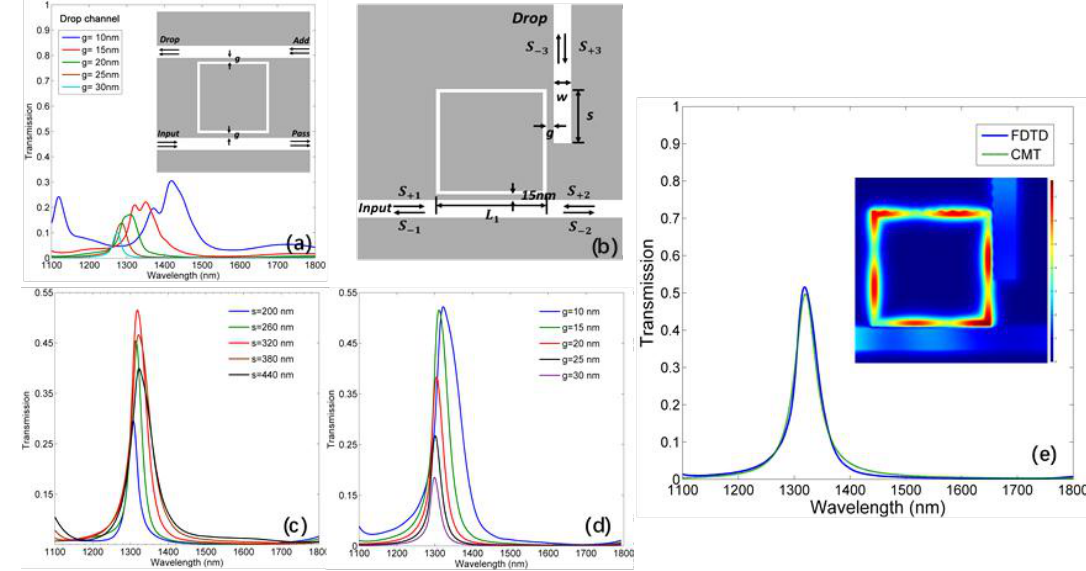
Figure 2. ( a ) The drop spectrum for the traditional add-drop SRR. ( b ) The schematic diagram of the band-pass filter. ( c ) The drop spectrum pertinent to different coupling lengths. ( d ) The drop spectrum pertinent to different gaps. ( e ) The transmission spectrum for a channel drop filter with L 1 = 546 nm, w = 100 nm, g = 15 nm, s = 320 nm from Finite-Difference Time-Domain (FDTD) and coupled mode theory (CMT). The inset is the field distribution of the channel drop filter.